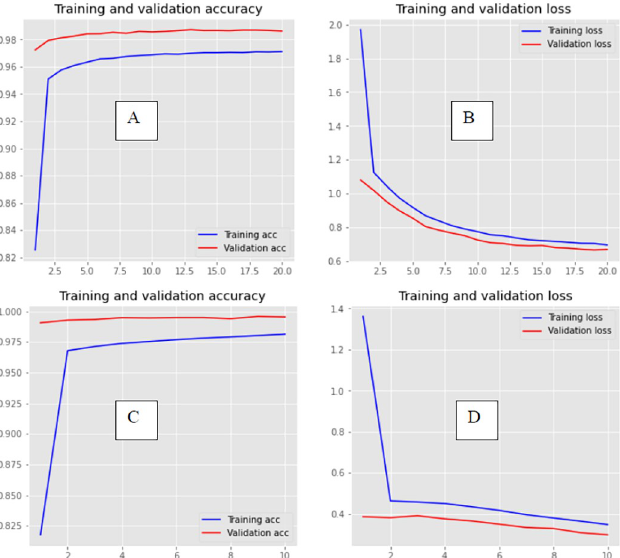
Fig 5. Training and validation accuracies without overfitting. (A, B- 1000 classes and 250 sequence length, C, D- 3000 classes and 100 sequence length) Left: Shows DeepHiFam model’s training and validation accuracy vs number of epochs. Right: Shows DeepHiFam model’s loss vs number of epochs. Both graphs show how the model learns without over-fitting.